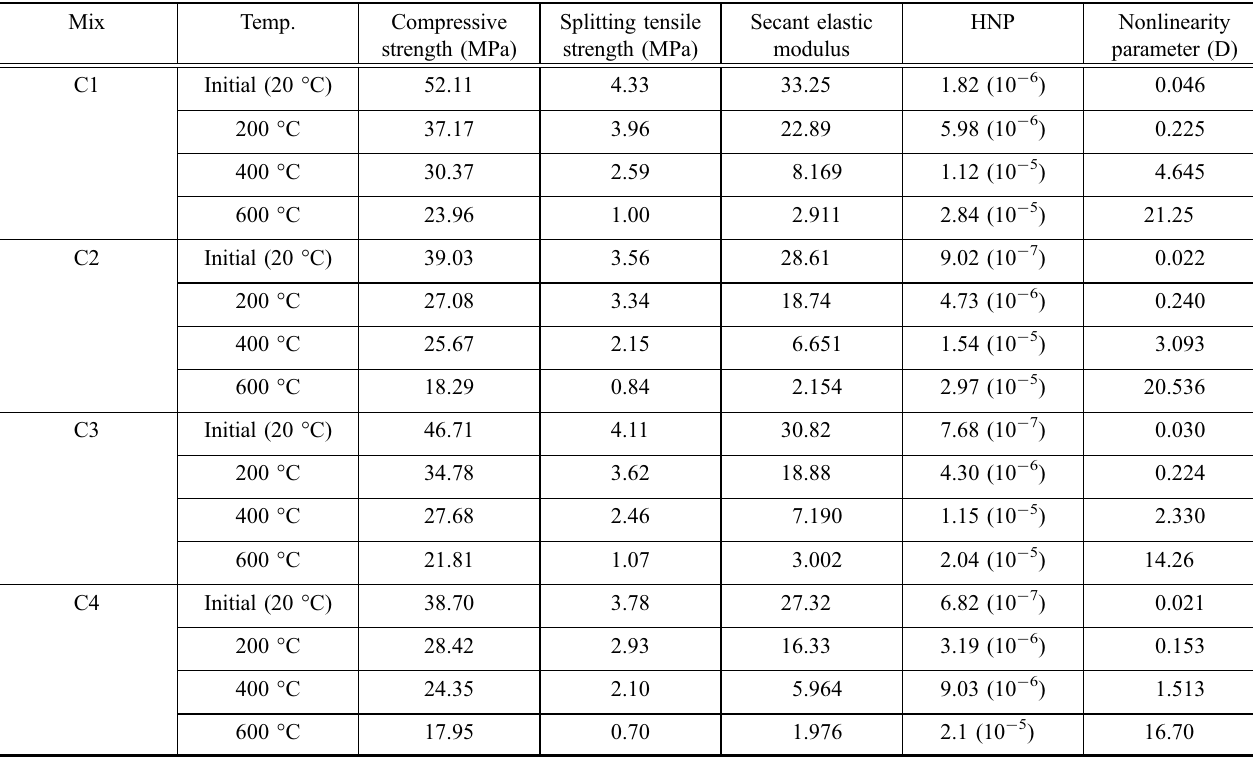
Table 2 The average results of destructive and non-destructive